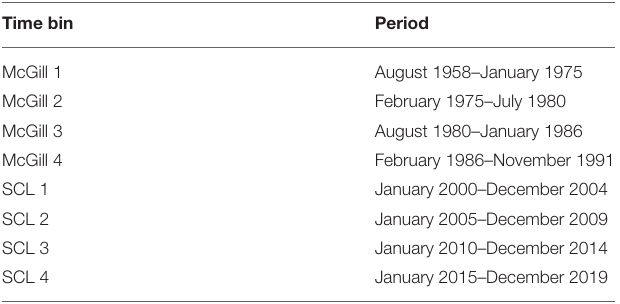
TABLE 1 | Four time bins and corresponding periods within which songs of each time bin were released for both the “past” and “present” aspects of this study. Time bin